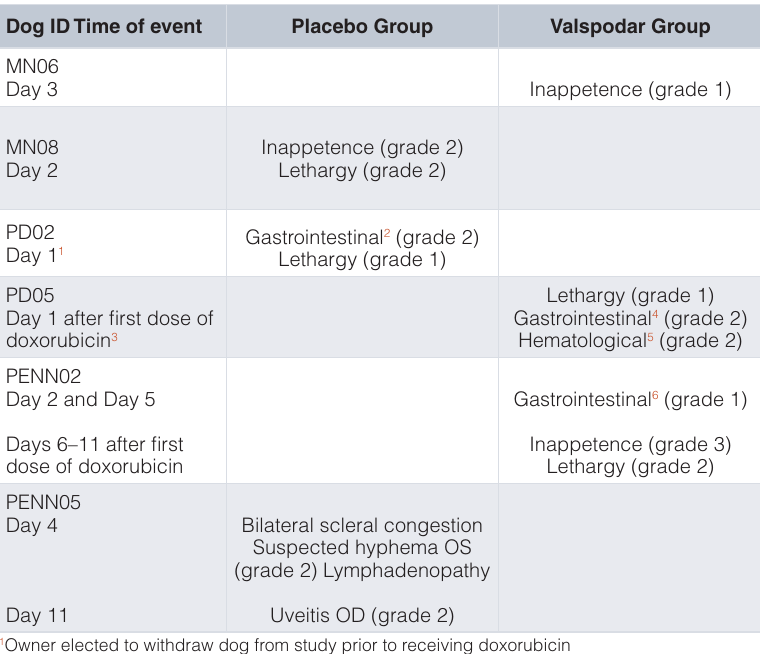
Table 3. Reportable events and treatment